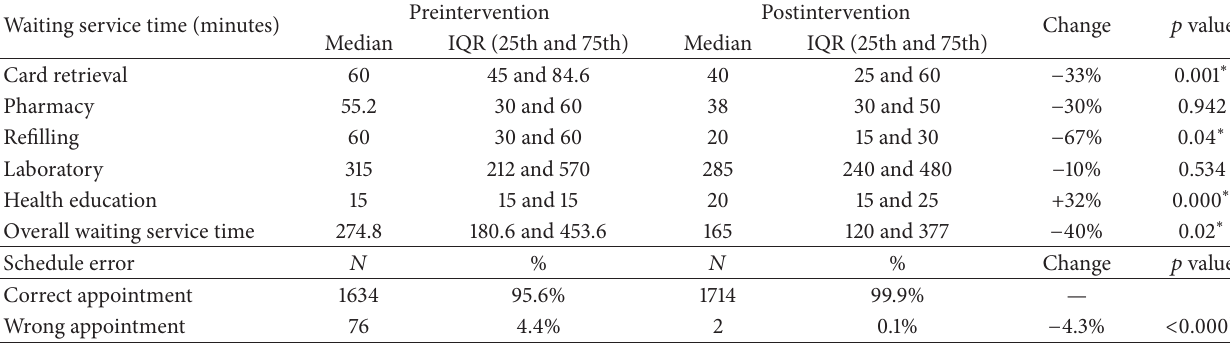
Table 2: Preintervention and postintervention waiting time and schedule error